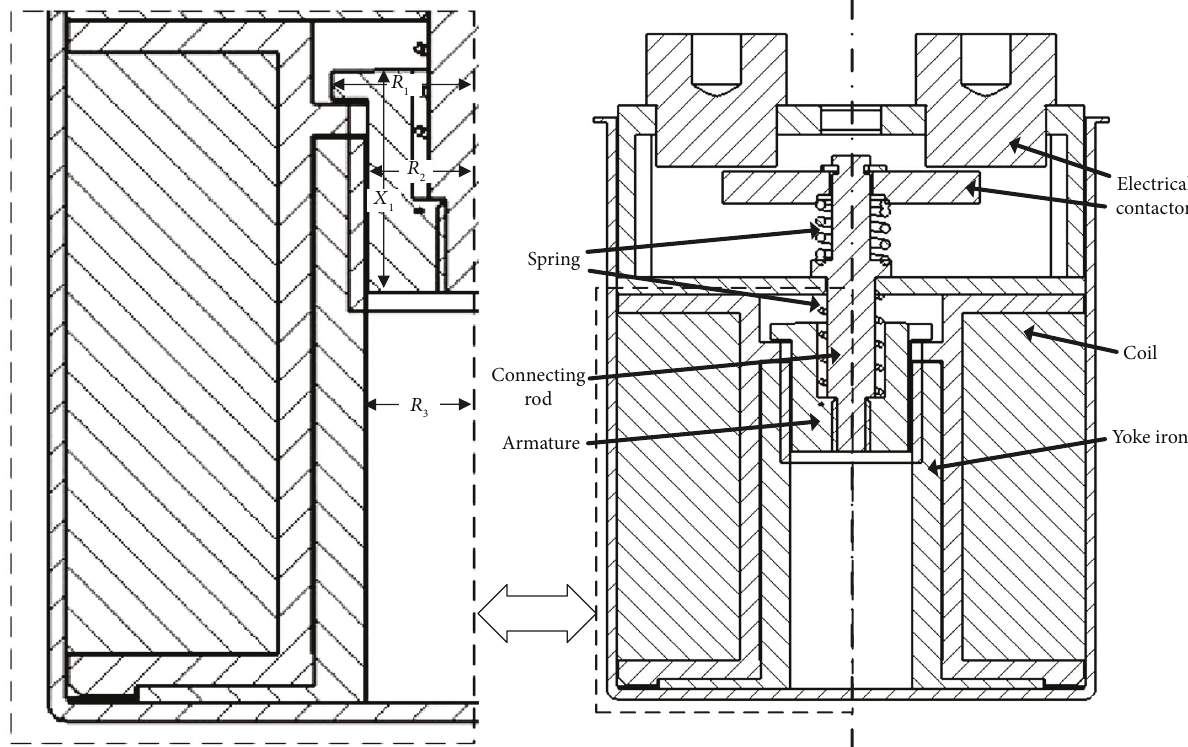
Figure 2: Structure of the typical direct-acting contactor.